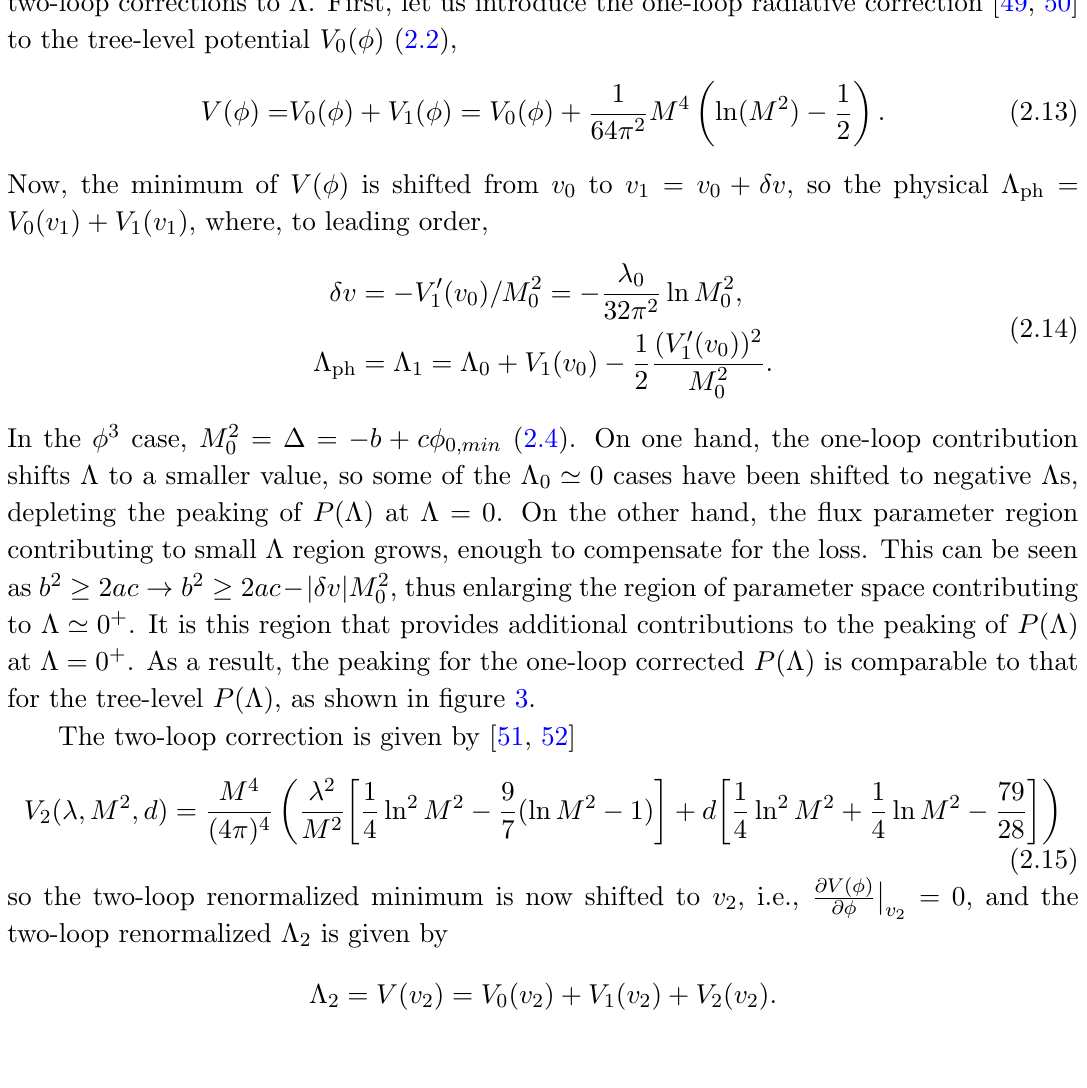
Figure 3 . The probability distributions P ((cid:3)) for the (cid:30) 3 ( c = 1) model for tree P ((cid:3) corrected P ((cid:3) 1 ) and two-loop corrected P ((cid:3) 2 ). Shown are the ratios between the distributions (numerical), P ((cid:3) 1 ) =P ((cid:3) 0 ) (red solid) and P ((cid:3) 2 ) =P ((cid:3) 0 ) (blue dash) at small values of (cid:3). The horizontal solid line at 1.0 stands for P ((cid:3) 0 ), which is shown in (cid:12)gure